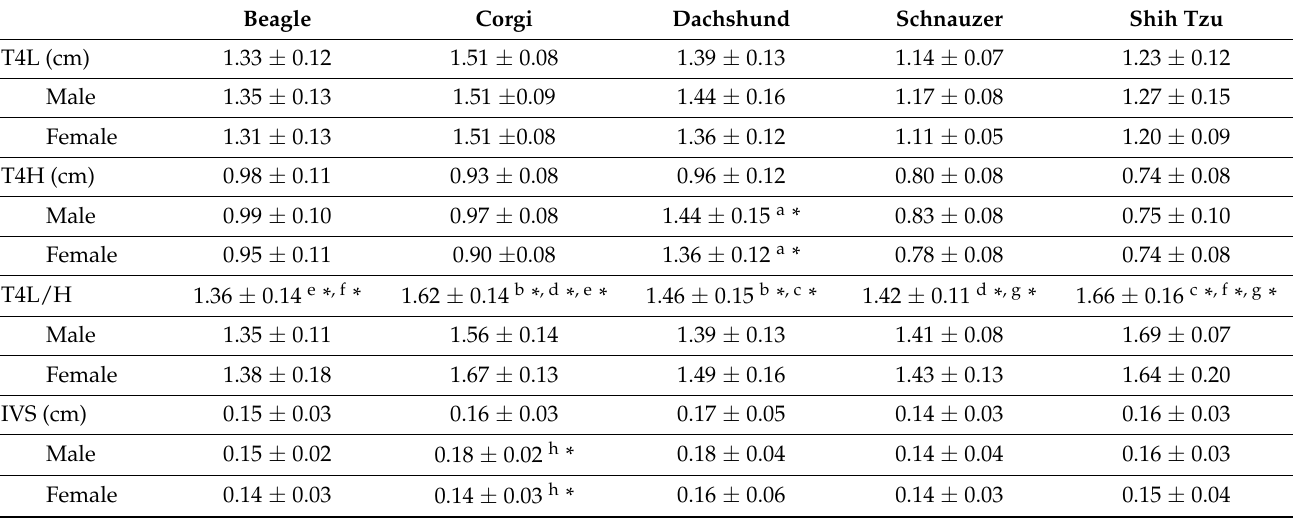
Table 2. The length and the height of the fourth thoracic vertebrae (T4L and T4H; cm) and the T4 length-to-height ratio (T4L/H) and the intervertebral disc space (IVS; cm) on the lateral radiograph among the Corgi, Shih Tzu, Schnauzer, Beagle, and Dachshund. Beagle Corgi Dachshund Schnauzer Shih Tzu